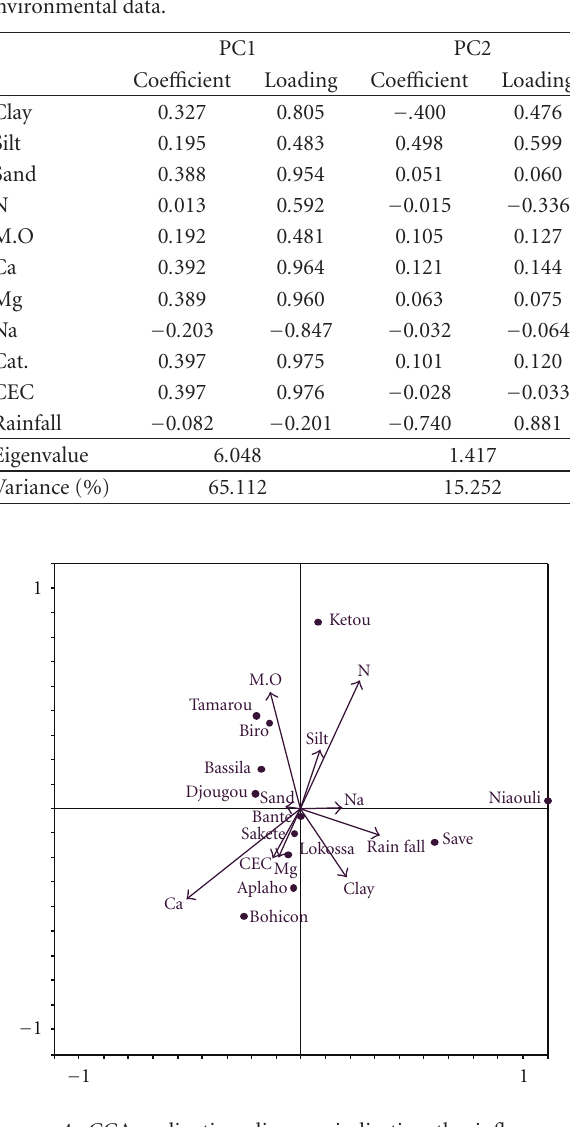
Figure 4: CCA ordination diagram indicating the influence of rainfall and edaphic factors on the morphological distribution of iroko